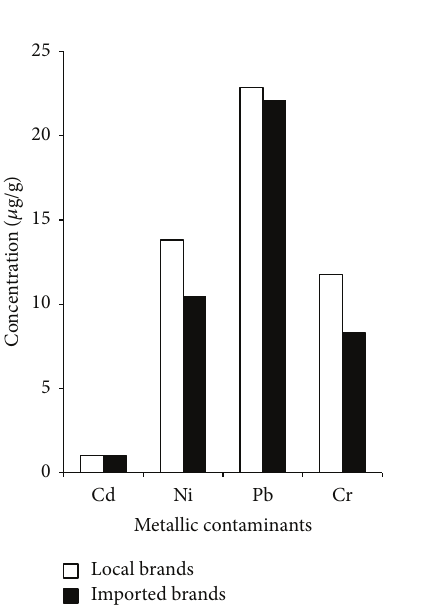
Highly significant difference ( 𝑃 < 0.01 ).